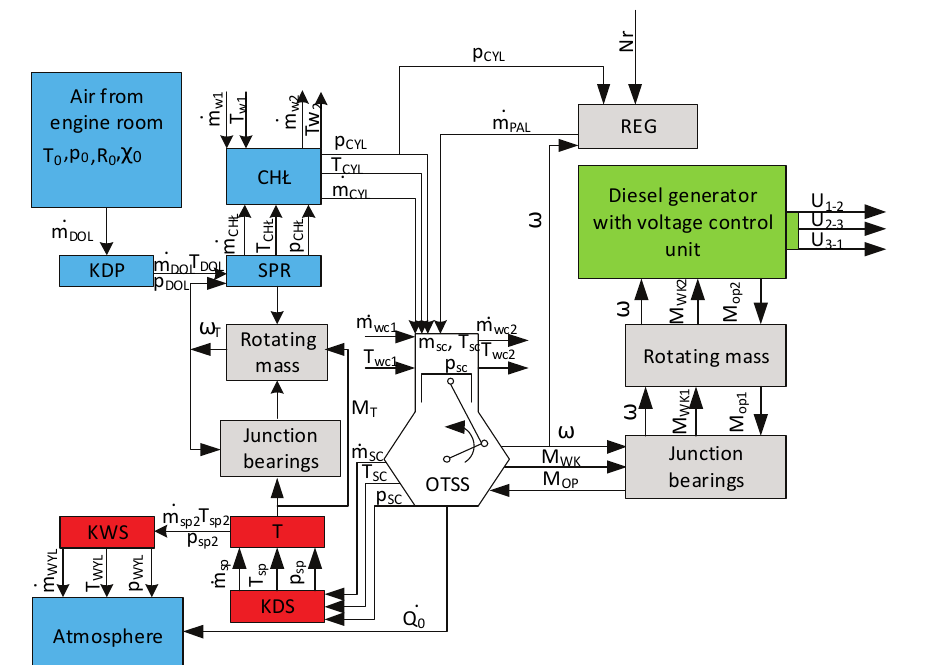
Fig. 2. Functional model of the engine-generator